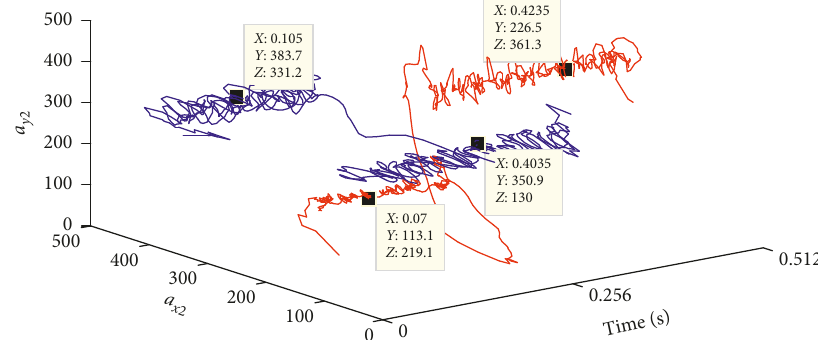
Figure 27: The three-dimensional time domain of a